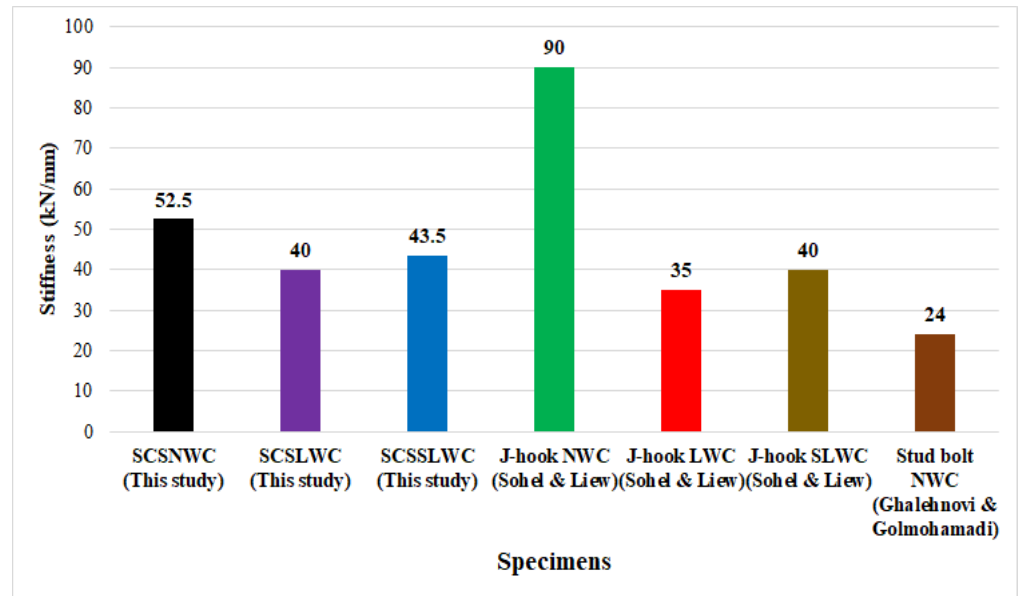
Figure 19. Compression between the stiffness of the specimens with different types of connectors.